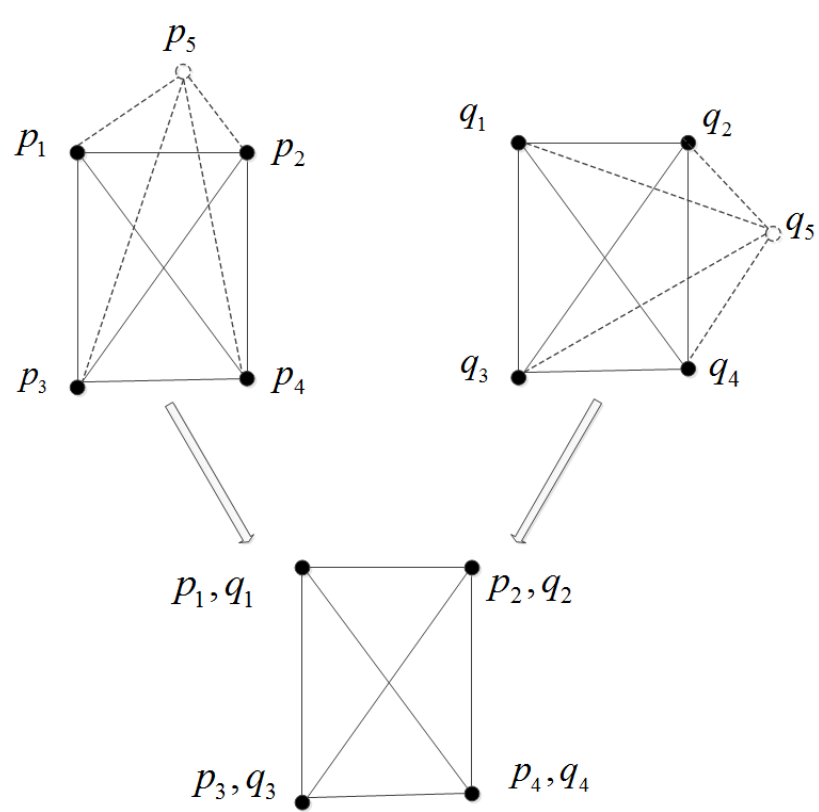
Figure 2. Geometry matching based on similar triangles. Based on the frequency that triangles match, we can easily get the corresponding points and conclude that p 5 and q 5 are noise or undetected